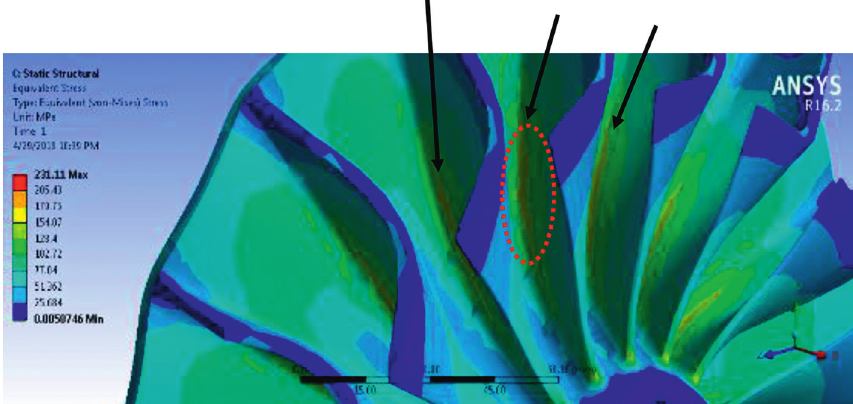
Figure 16: High magnification of The contour of Von-Mises for 0.1 pressure difference in